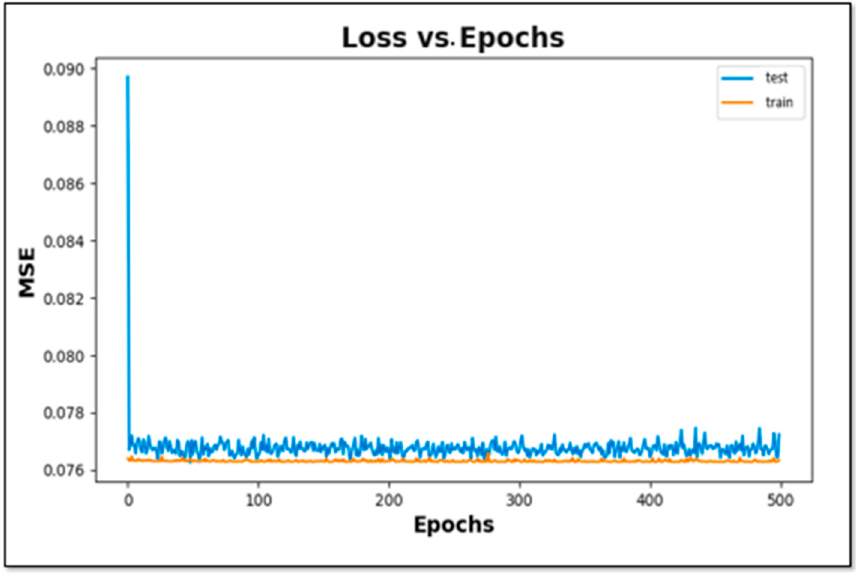
Figure 7. Loss function with 500 epochs for ANN model, batch size of 256.